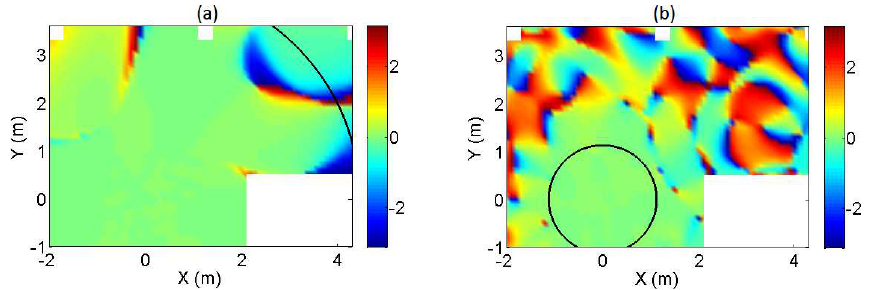
Figure 7. Phase error of the reference room at 63 Hz ( a ) and 250 Hz ( b ).